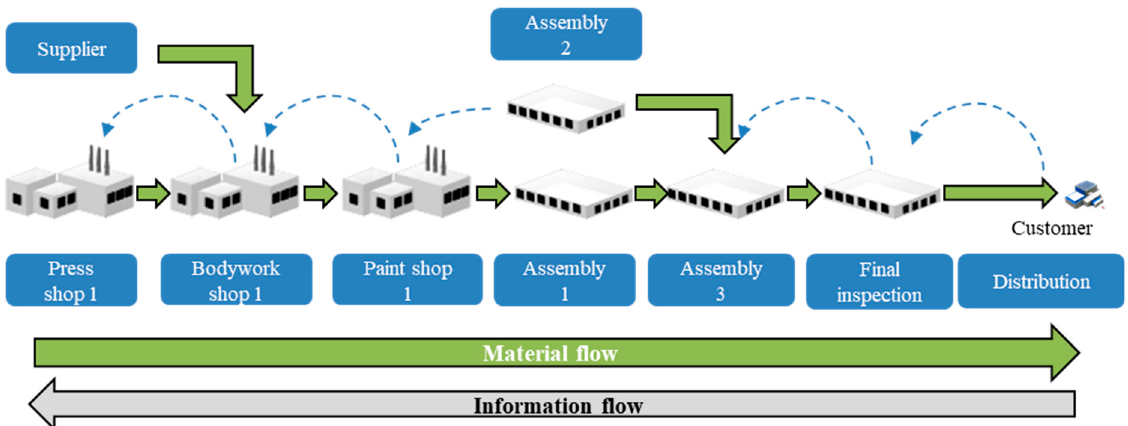
Figure 14. Simulated production flow (own elaboration).